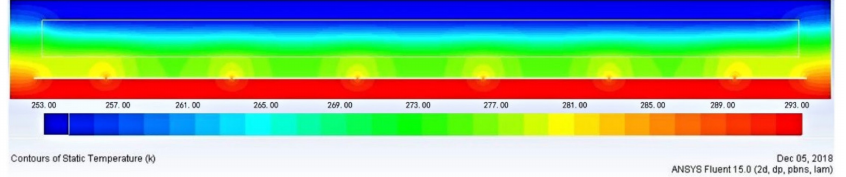
Figure 7. Temperature distribution cloud map of CVG (NLC).